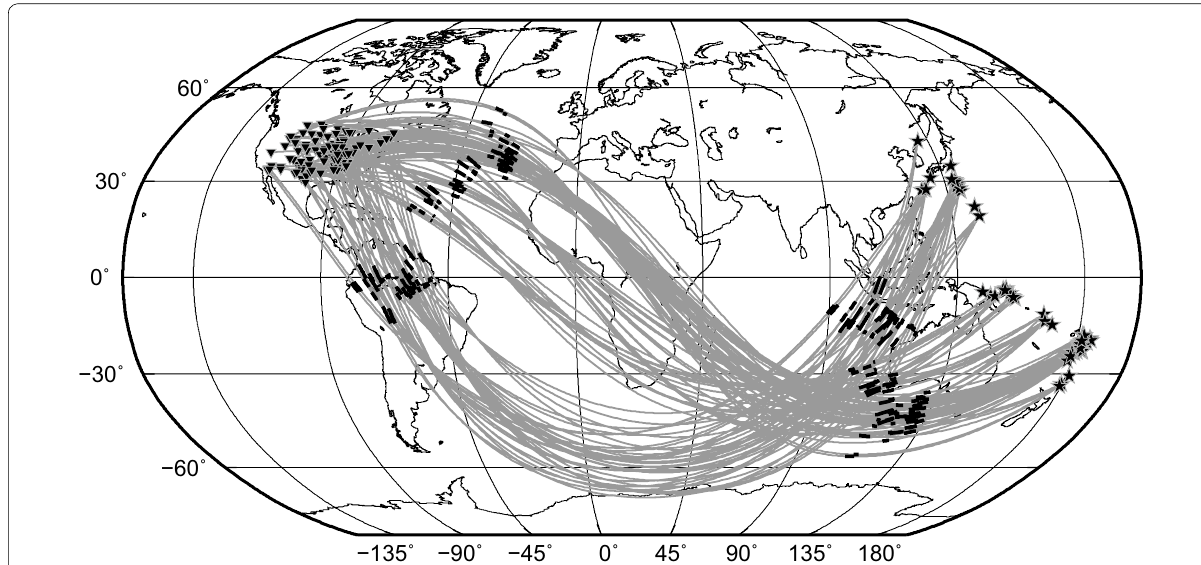
Fig. 2 Map showing the distribution of the earthquakes ( black stars ) and stations ( black inverted triangles ) for PKKP ab diffraction data analysis. Earthquakes and stations are connected with major-arc paths ( gray lines ). For a group of ray paths with similar azimuths, we choose the one with a median distance value as the represented ray path and only plot those represented rays. The diffracted paths of PKKP ab diffraction waves along the CMB are shown as black lines on both the source and receiver